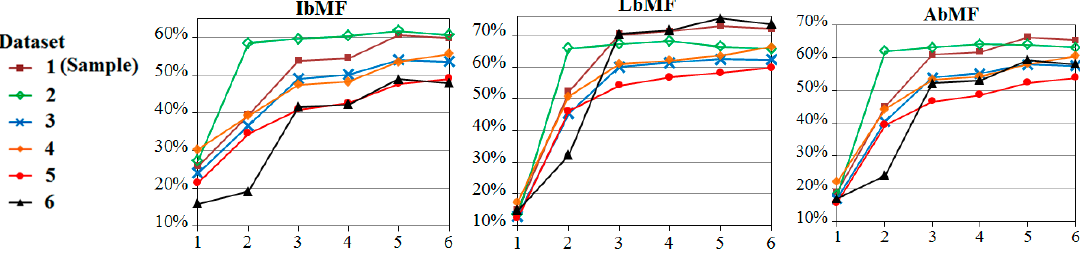
Figure 23. Coincidence evaluation between the LiDAR shadow products (in the chain in Figure 22) and the ISM.